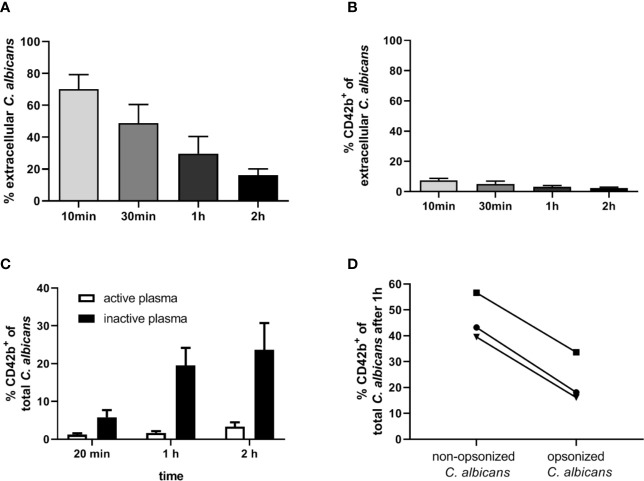
Interaction of human platelets with C. albicans during whole-blood infection is influenced by complement opsonization. (A) The percentage of extracellular C. albicans during human whole-blood infection was investigated via flow cytometry and calculated relative to total fungal cells in blood (set to 100%) of five independent experiments with blood from different donors. A steady reduction of extracellular fungi over time was observed (1-Way ANOVA and Test for linear trend, p<0.0001). (B) Less than 10% of extracellular C. albicans cells showed a CD42b+ staining at each time point, reflecting a low platelet binding to C. albicans in human whole-blood (n = 5). (C) Isolated human platelets were confronted with C. albicans either in the presence of non-treated (active plasma) or heat-inactivated autologous plasma (inactive plasma). Co-incubation in medium containing active plasma prevented the time-dependent increase in platelet-C. albicans interaction as observed for heat-inactivated plasma. Significantly less CD42b-positive fungal cells were observed with active compared to inactive plasma at each time point (unpaired, two-tailed t-test, p<0.0001, n = 7). (D)
C. albicans cells were either pre-incubated in non-treated (C3b-opsonized C. albicans) or heat-inactivated autologous plasma (non-opsonized C. albicans, no surface C3b) before confrontation with isolated human platelets in medium with inactive plasma for 1 h. Opsonization of C. albicans resulted in a markedly lower association with platelets compared non-opsonized C. albicans (p = 0.035, unpaired, two-tailed t-test).